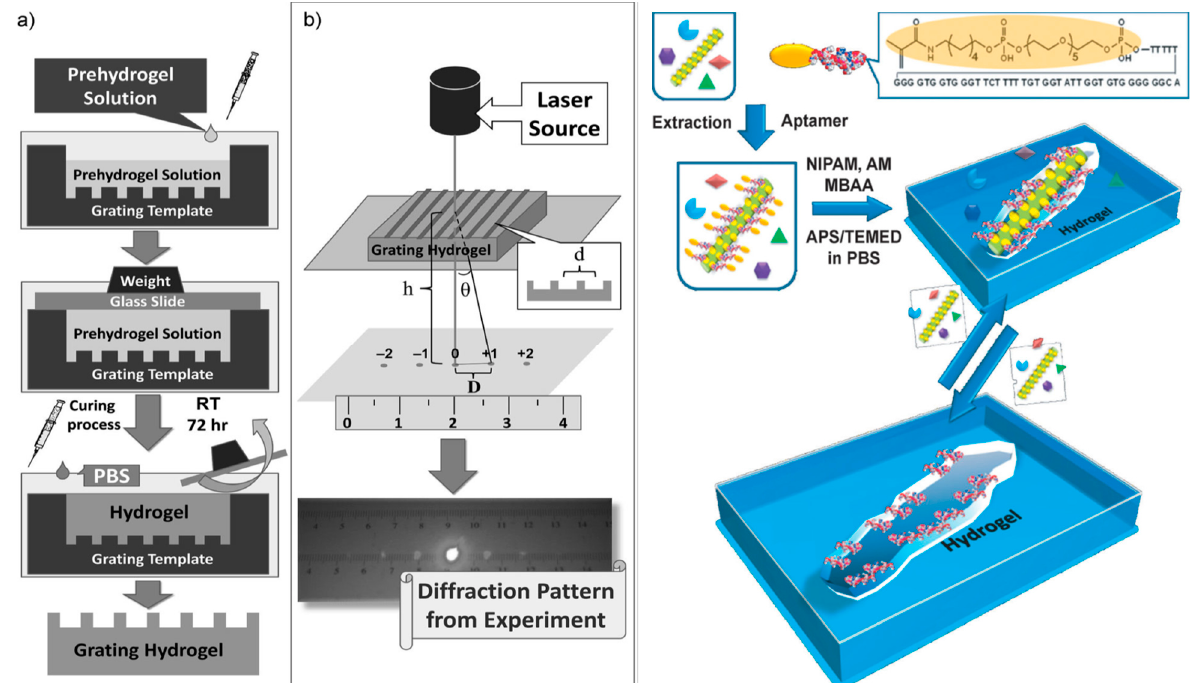
Figure 4. ( a ) Preparation of “double imprinted” diffraction grating bioimprinted hydrogels for MIP-GLaDiS materials. ( b ) Schematic of the laser diffraction apparatus used for the measurement of the laser diffraction pattern projected onto a desk ruler (left). Outline of the bioimprinting process used to create virus responsive super-aptamer hydrogels. NIPAM = N-isopropylacrylamide, AM = acrylamide, MBAA = N,N’-methylene bisacrylamide, APS = ammonium persulfate, TEMED = N,N,N’,N’-tetramethylethylendiamine, PBS = phosphate-buffered saline (right) (Reproduced with permission from Reference [68]).